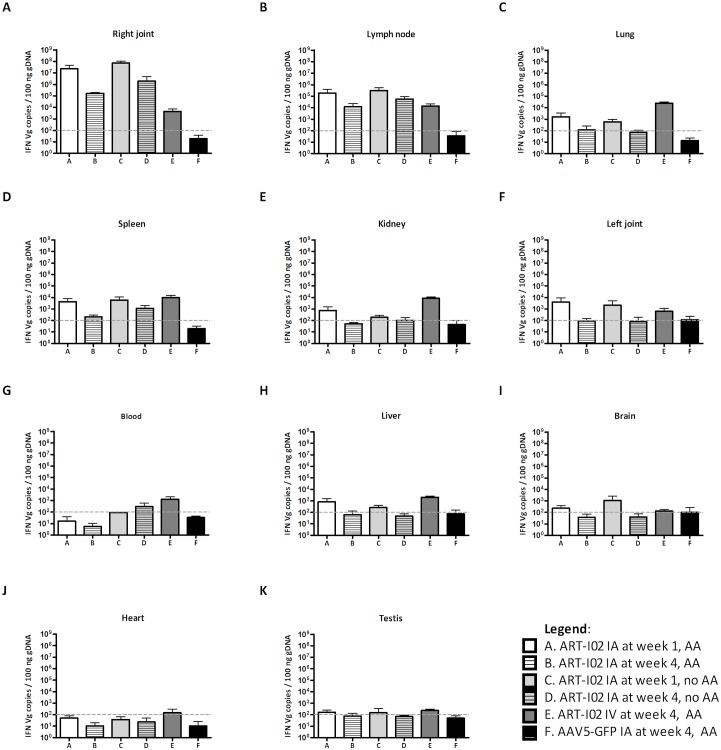
Vector copies of ART-I02 detected per tissue after intra-articular or intravenous administration.Besides in the intra-articularly injected right joint, high copy numbers were observed in draining lymph nodes and lung tissue. Intermediate numbers of vector copies were detected in spleen, kidney and blood, low numbers in liver, blood and brain. Levels in heart and testis were very low or below the detection limit of the assay. Data shown are mean + SD, graphs are shown with logarithmic scale. The 100 vg copies detection limit is depicted with a gray dashed line. N = 6 per group. GFP, green fluorescent protein; IA, intra-articular; IV, intravenous; week 1 or 4, number of weeks after vector administration; AA, adjuvant arthritis model.